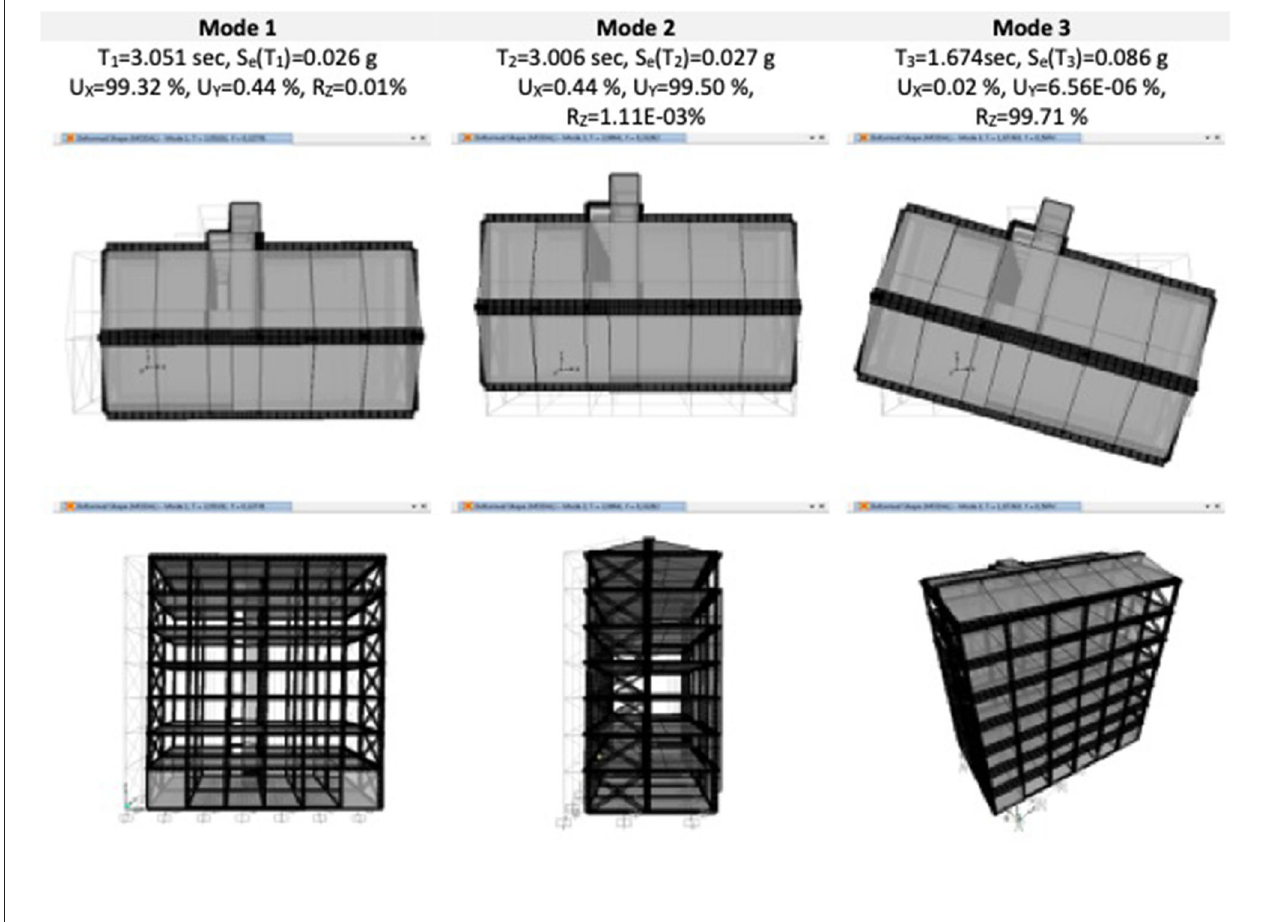
FIGURE 9 | BI model. Shapes and modal properties of the first three vibration modes referred to (secant stiffnesses for LSLS).